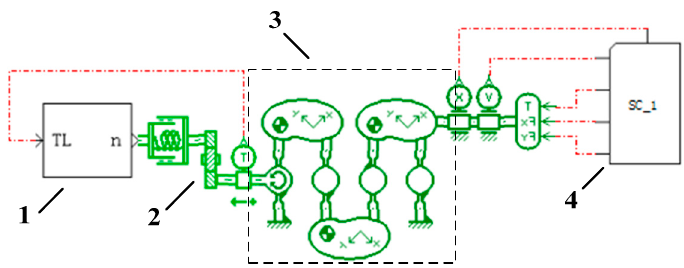
Figure 4. Beam pumping unit model. 1. Simulink-AMESim interface model; 2. reducer model; 3. four-link mechanism model; and 4. polished rod load.